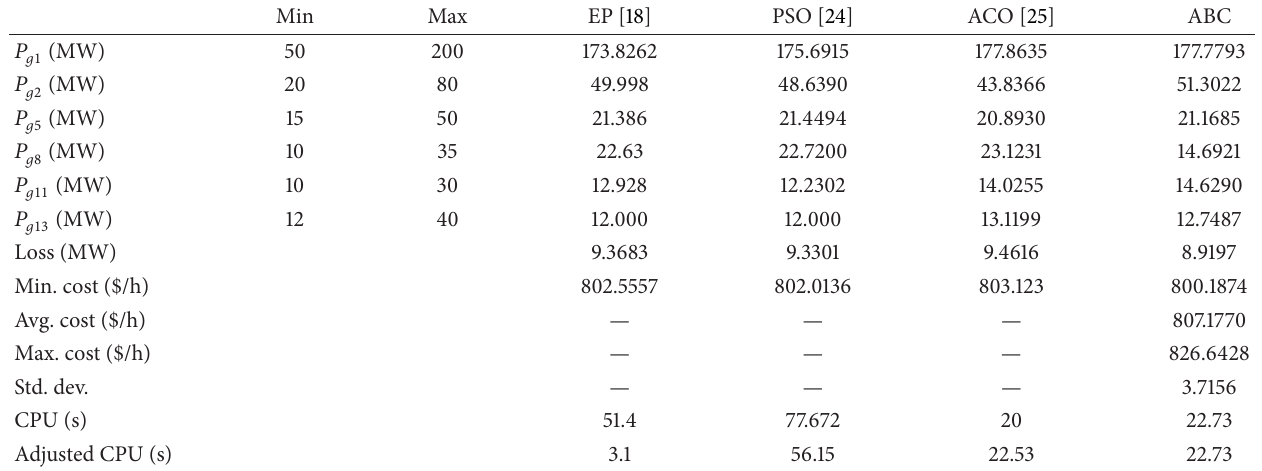
Table 1: Result comparison for the IEEE 30-bus system with quadratic fuel cost functions.